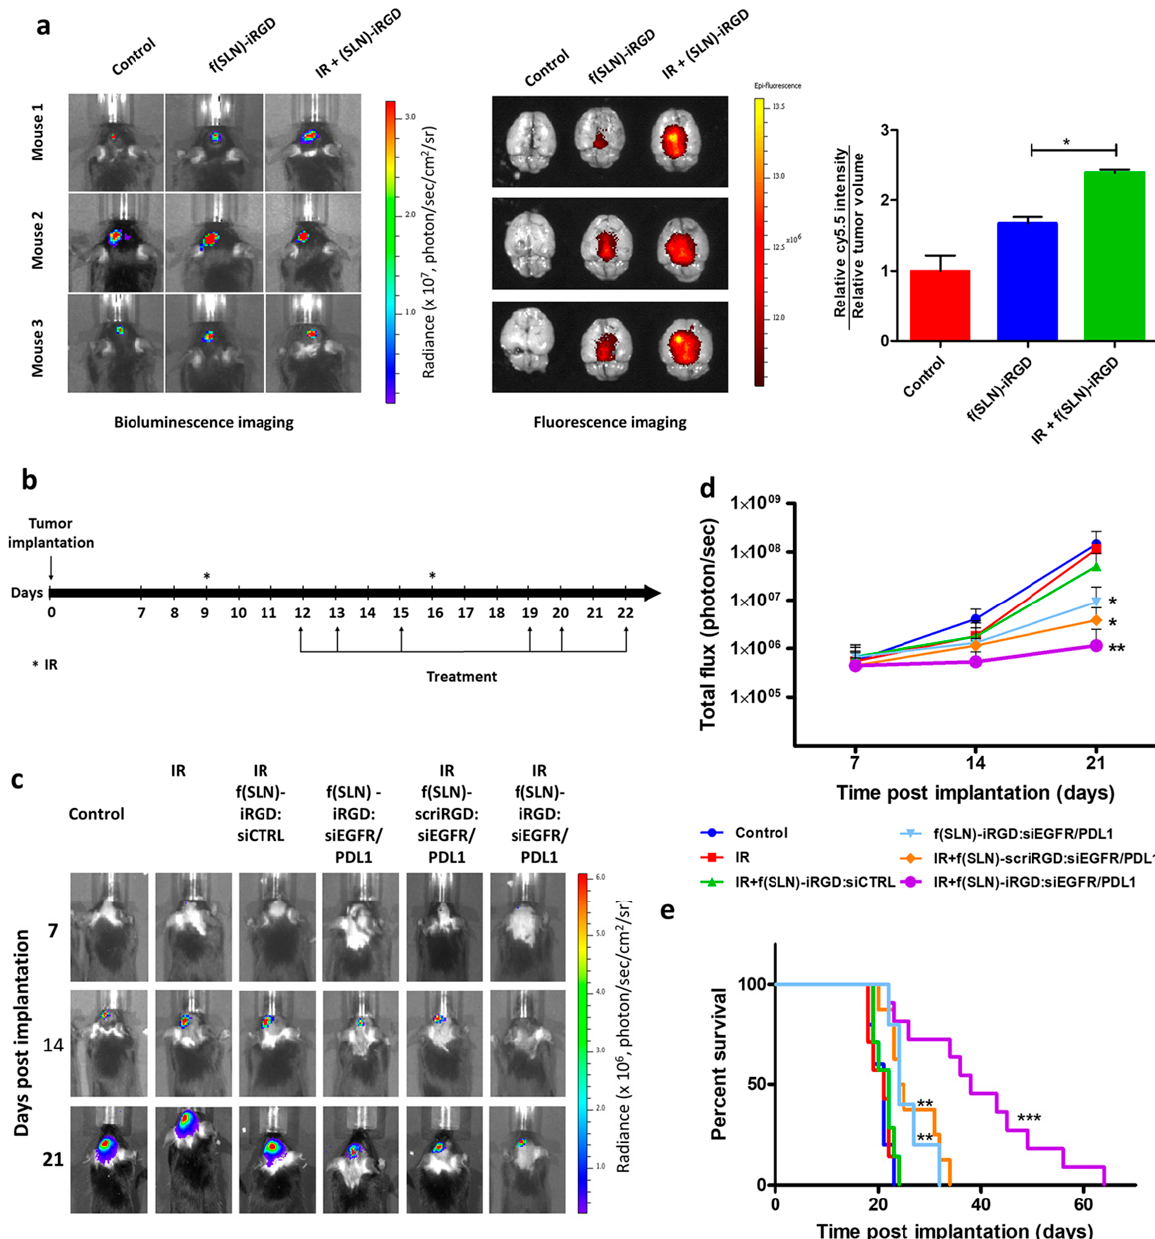
Figure 4. Radiation primes glioblastoma for SLNs targeted delivery. ( a ) Mice bearing GL261-Fluc tumors were irradiated (or not as control) and, three days later, received retro-orbital administration of f(SLNs)-iRGD:Cy5.5 or PBS control. Twenty-four hours post-injection, tumor volume was first evaluated by Fluc imaging (left), and brains were removed and imaged ex vivo for Cy5.5 (middle). The mean fluorescence intensity was calculated and normalized to tumor volume (right; n = 3, * p < 0.05). ( b – f ) Mice bearing GL261-Fluc tumors were irradiated (or not as a control) and retro-orbitally